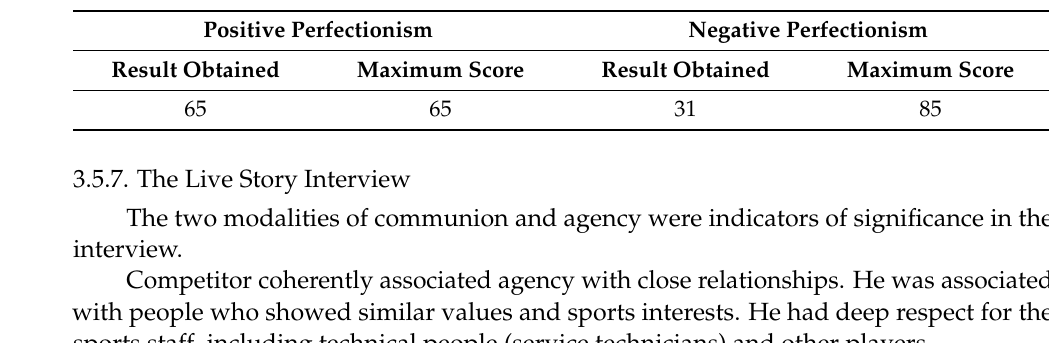
Table 14. The results of